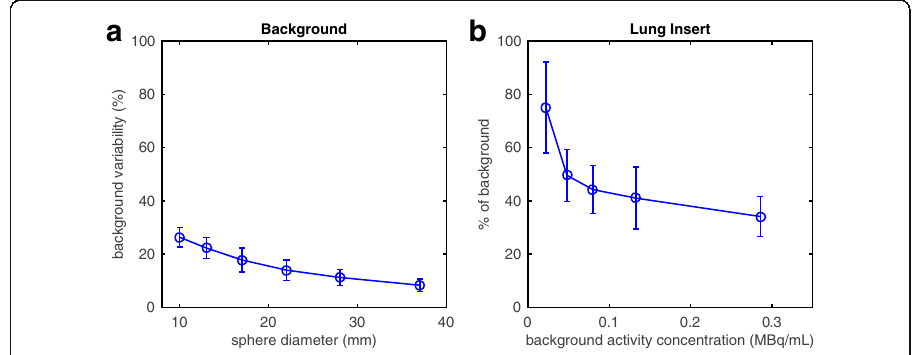
Fig. 4 a Variability in measurements between 12 × 8 background VOIs for each sphere size. b Misplaced counts in cold lung insert reported as percent of true background activity concentration. Each point represents the mean. Error bars represent one standard